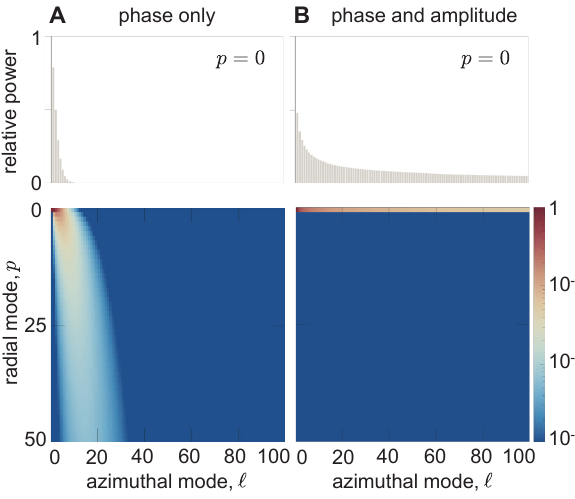
Figure 3: Purity efficiency of phase-only and phase-amplitude